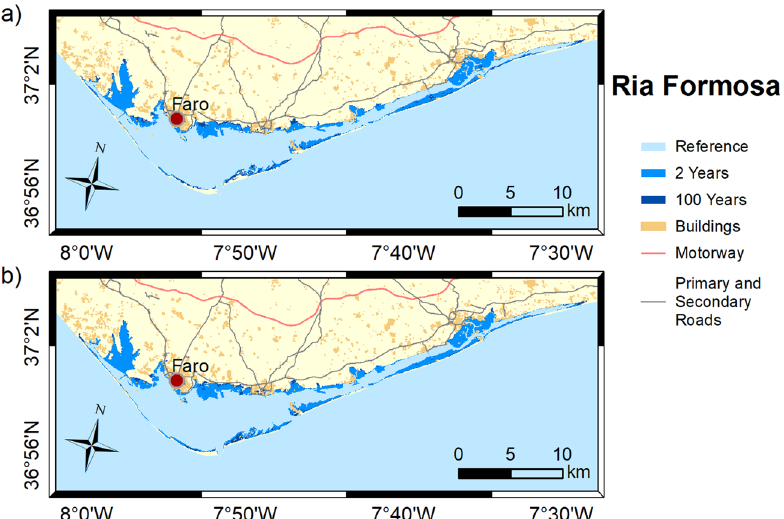
Figure 7. Inundation extents induced by extreme sea levels with return periods of 2 and 100 years on the Ria Formosa in: ( a ) 2046–2065; and ( b ) 2081–2100. These maps were created with Esri ArcGIS 10.8 software (https:// www. esri. com/ en- us/ home).